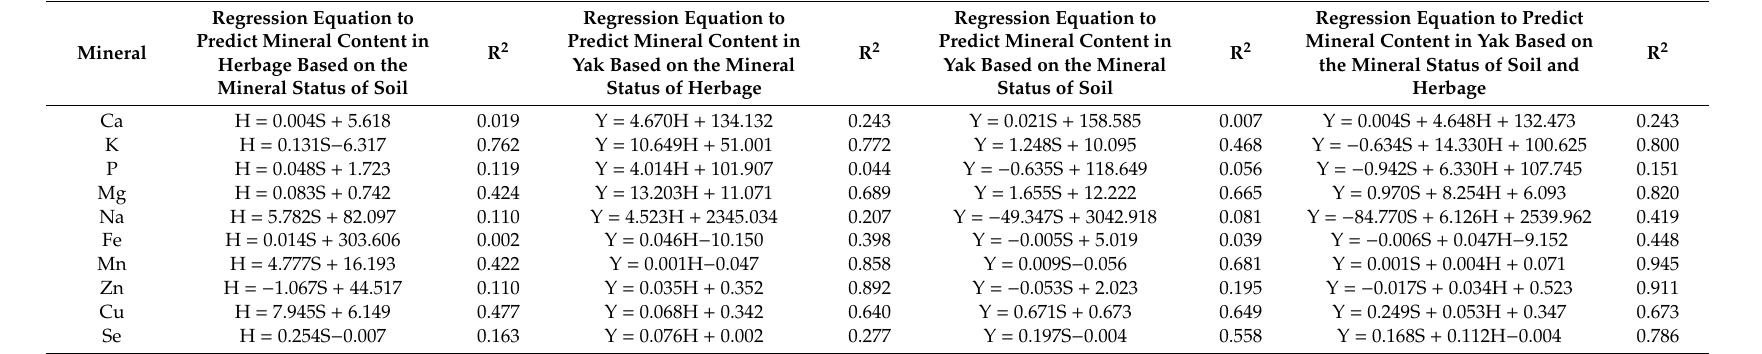
Table 8. Regression equation of the soil–plant–yak continuum in relation to mineral status in summer.